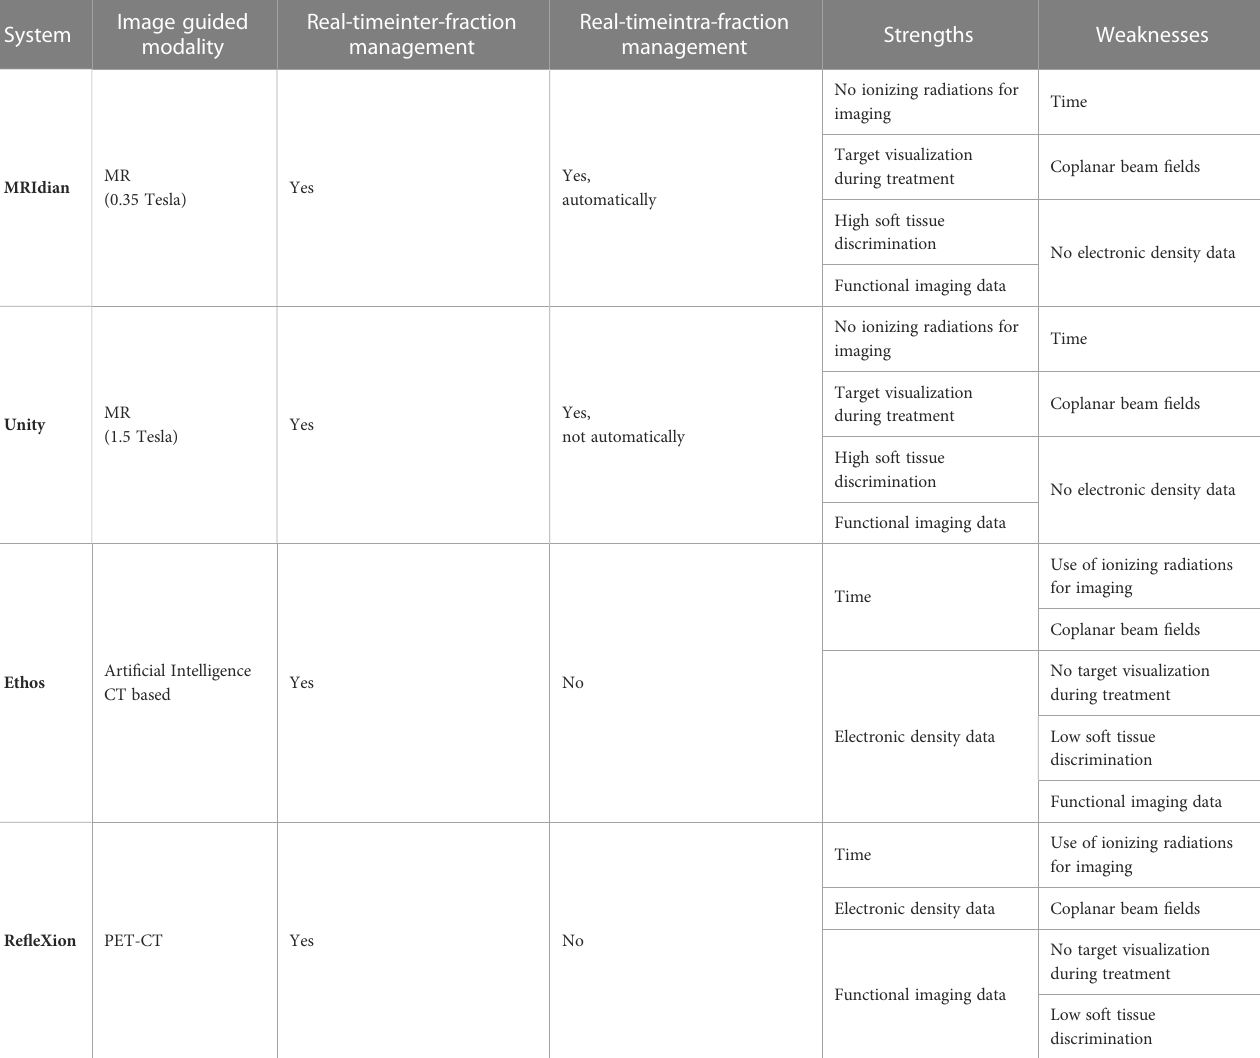
TABLE 1 Commercially available radiotherapy platforms specializing in adaptive image-guided and biology-guided radiation therapy.